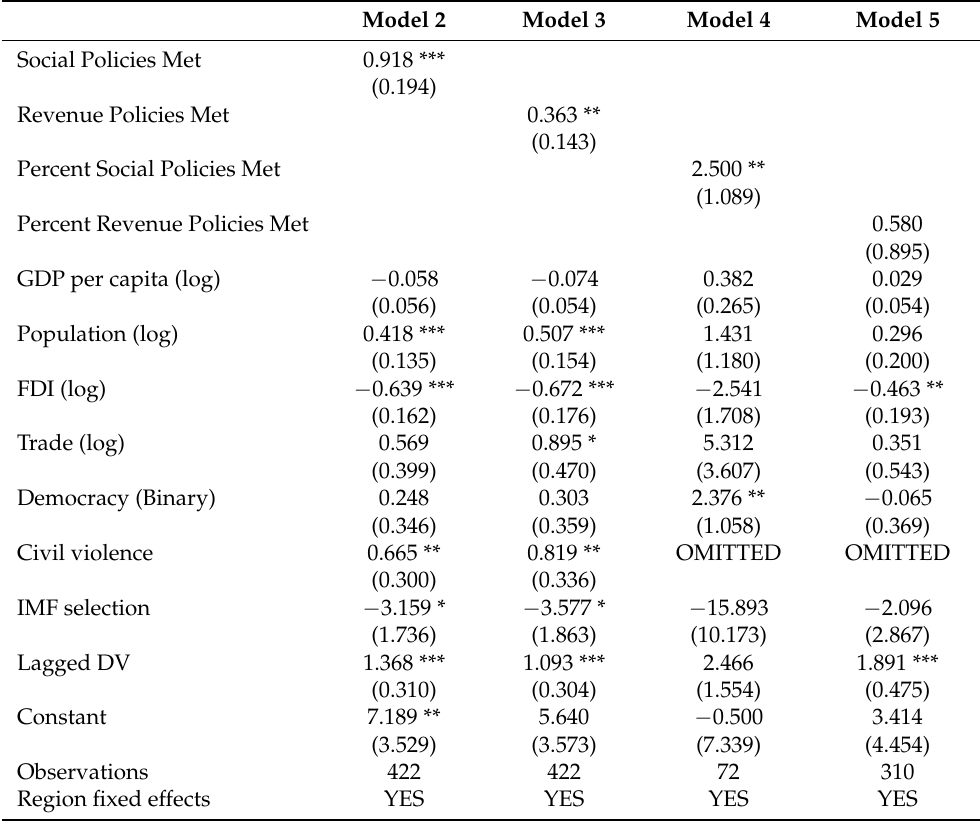
Table 2. Probit Model Results. DV: 0 = No Child Labor 1 = Child